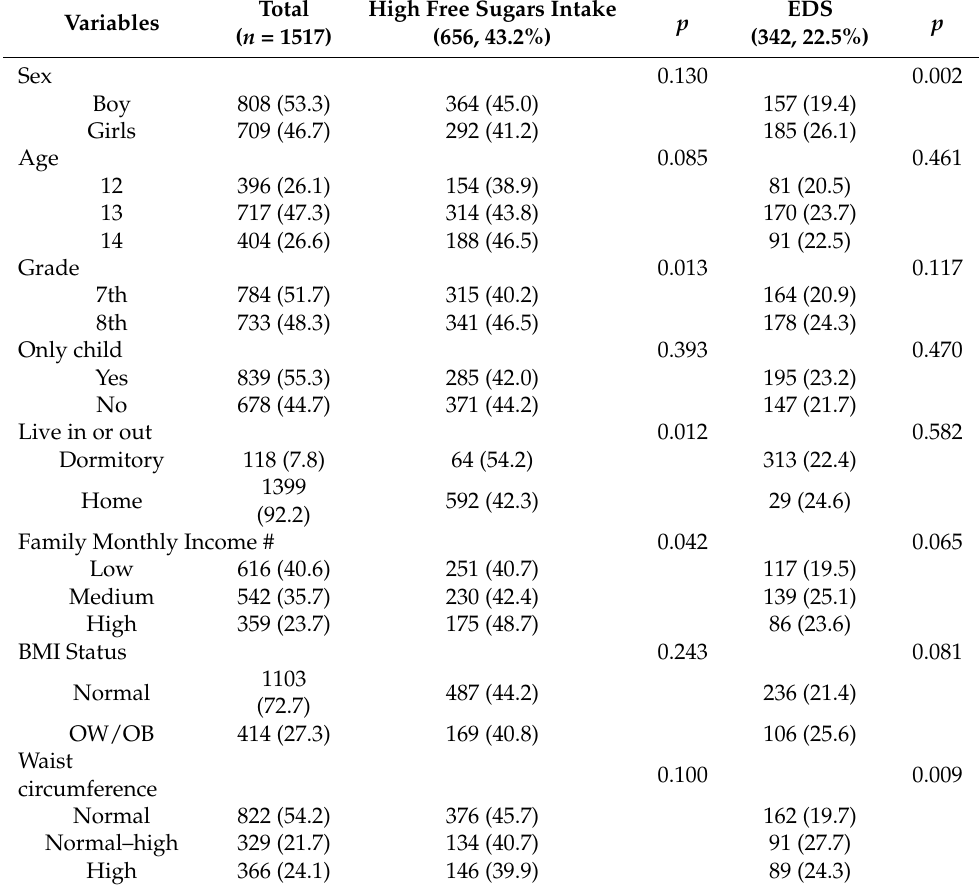
Table 1. Characteristics of adolescents by outcome variables ( n = 1517, mean ± SD